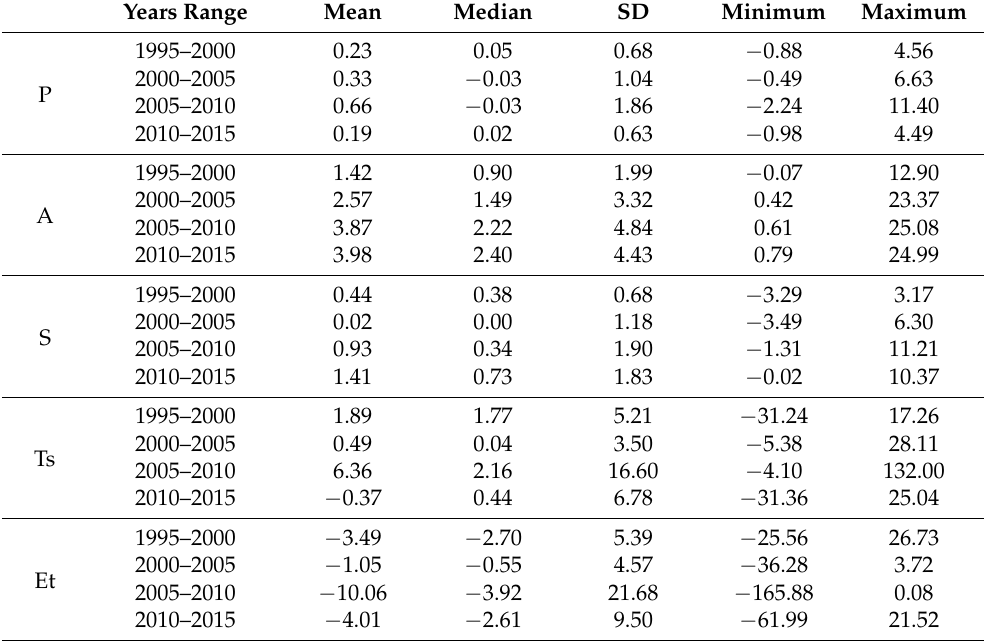
Table A4. Summary of factors’ decomposition for 73 counties in